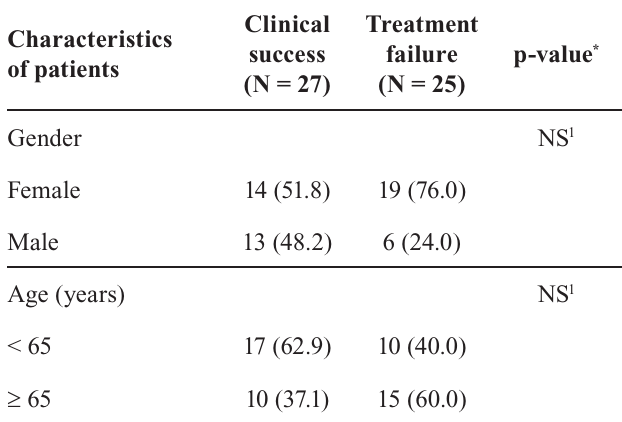
TABLE I - D emographic and clinical characteristics of the 52 patients undergoing daptomycin therapy. Brazil,